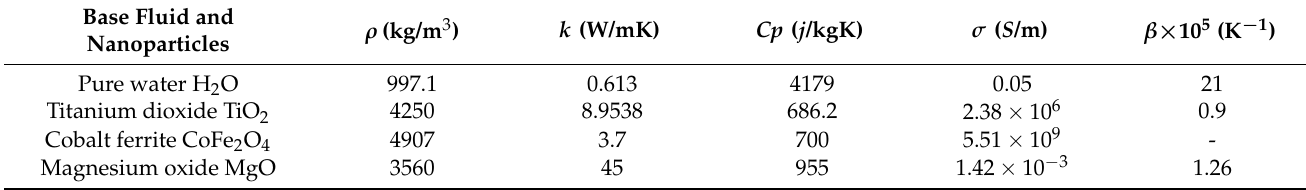
Table 1. The experimental values of Titanium dioxide, Cobalt ferrite, magnesium oxide water [32,33].